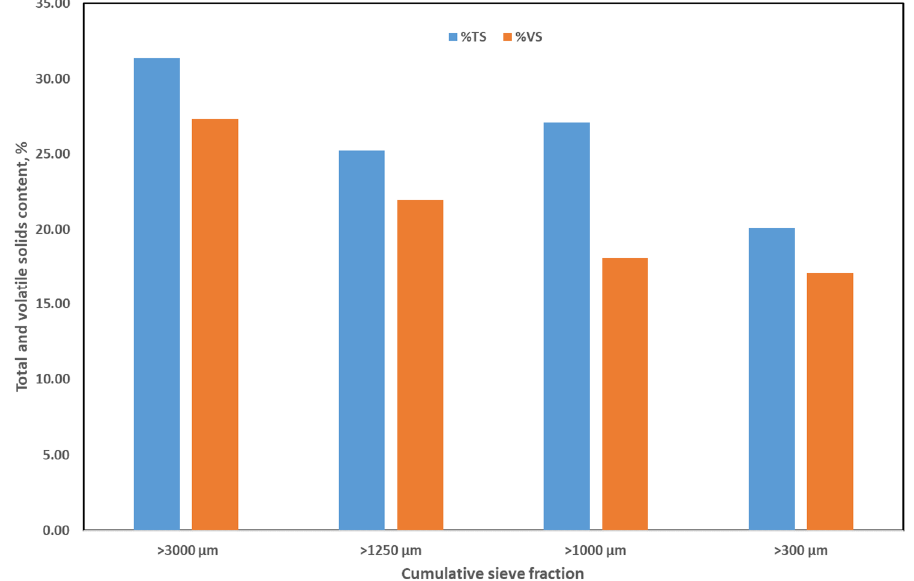
Figure 4. Concentration of total and volatile solid content in cumulative solid samples collected from sieves with openings of certain sizes.